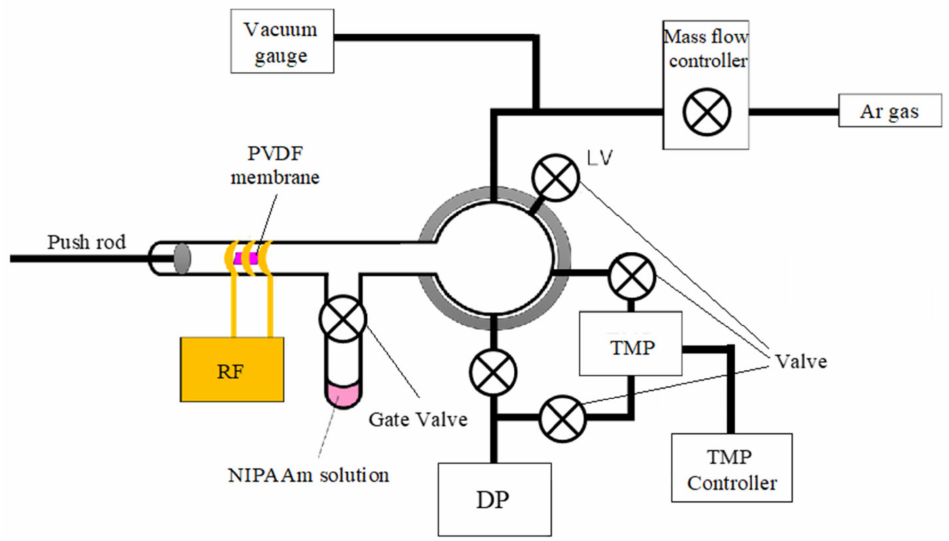
Figure 3. Schematic of the proposed plasma-induced graft polymerization system. A PVDF mem- brane can be dropped into the NIPAAm solution without exposure to the atmosphere by pushing with a push rod after plasma irradiation. RF; radio frequency power source. TMP; turbo molecular pump. DP; diaphragm